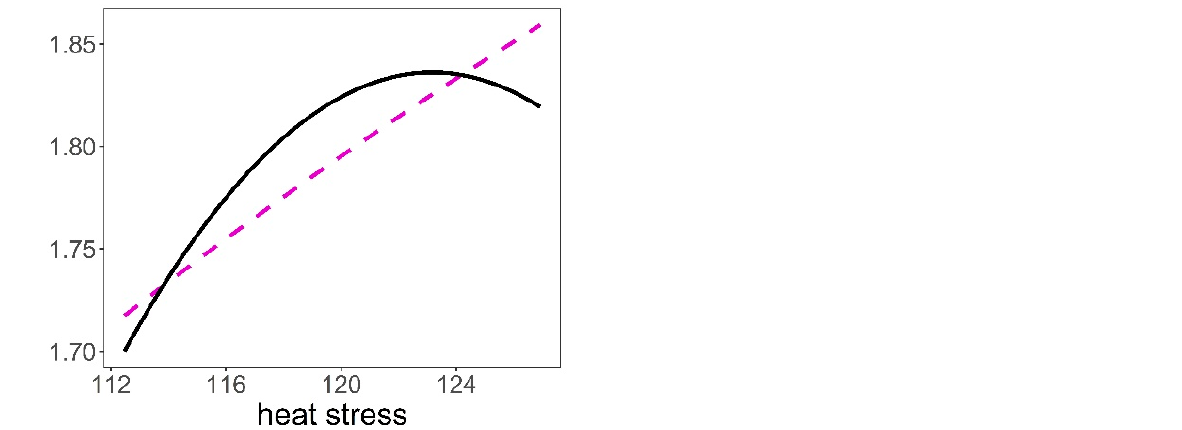
Figure 5. Predictions of the response of pelt biting to heat stress (THIWS, see Methods), group size, age (year), body weight (kg), and date of birth (DOY, day of year) based on model in Table 4. Male (black continuous line), female (magenta dashed line), mean date of births (vertical red dotted line). Variables not present in the plots were fixed to their means. Table 5. Coefficients and statistics of a polynomial mixed model to assess hypothesis H5 (in Table 1) on pelt biting. Female is the sex of reference. Other acronyms as in Table 3.